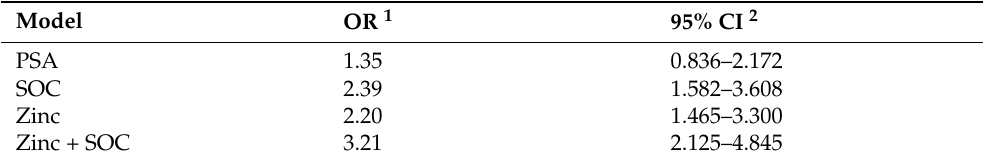
Table 3. Odds ratios, 95% confidence intervals for